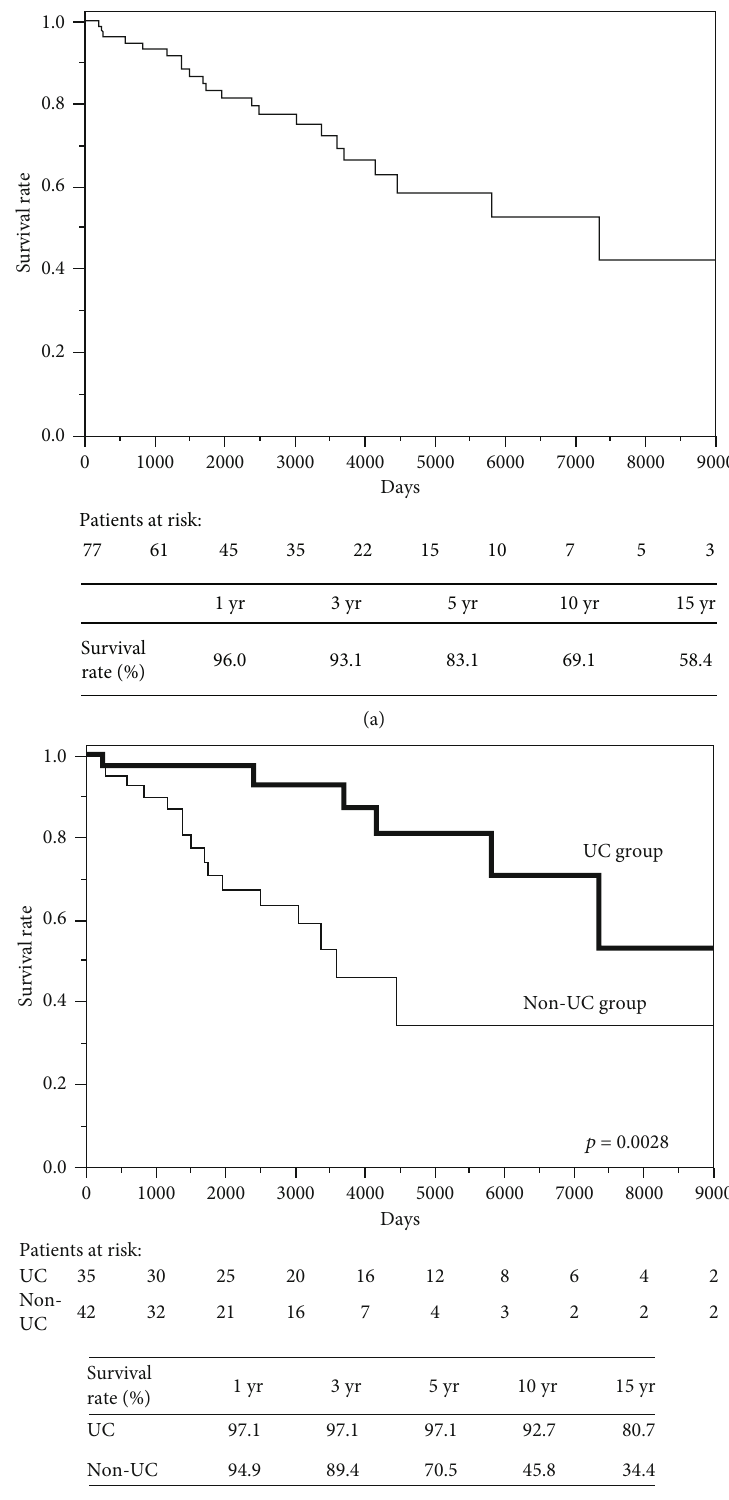
Figure 2: (a) Survival rate: the total PSC cohort ( n = 77 ). (b) Survival rate: PSC and PSC complicated by